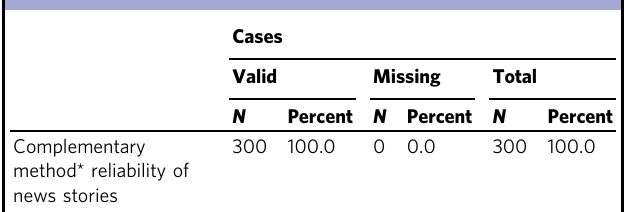
Table 6 Case Processing Summary.